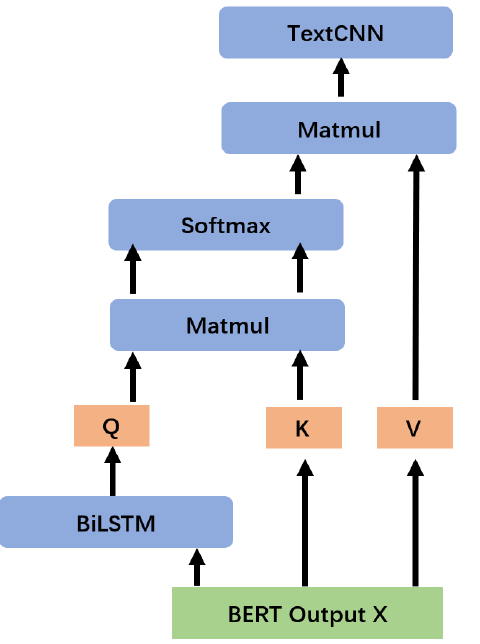
Figure 2. Cross attention (CA) process. The inputs of CA are derived from the BERT encoder, and CA can essentially be described as a mapping from a query to a set of key–value pairs, where the key is derived from BiLSTM’s output. Please see Section 3.4 for calculation